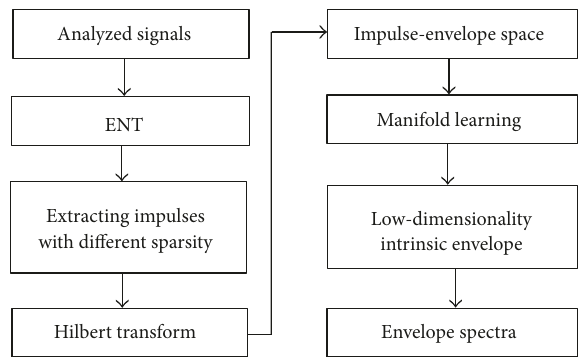
Figure 1: Fault detection flowchart of the impulse-envelope